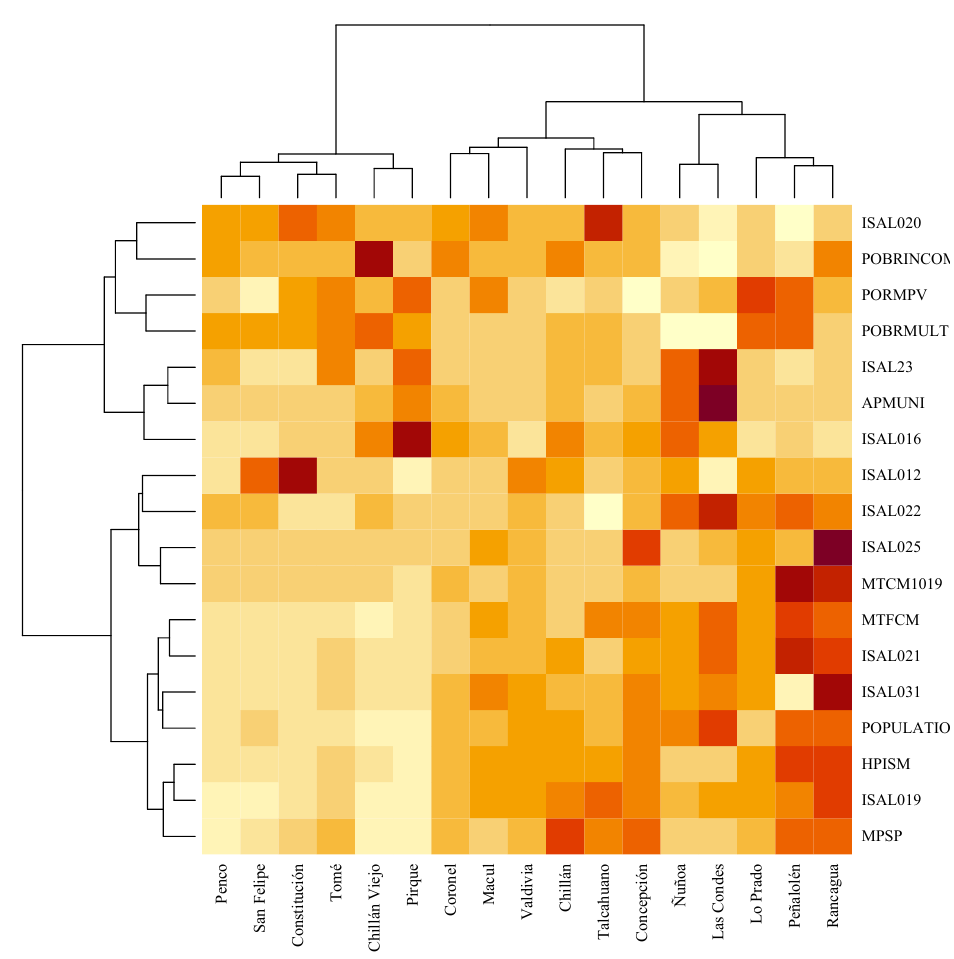
Figure 5. Hierarchical analysis with heat map for communes and variables; method—ward.D;